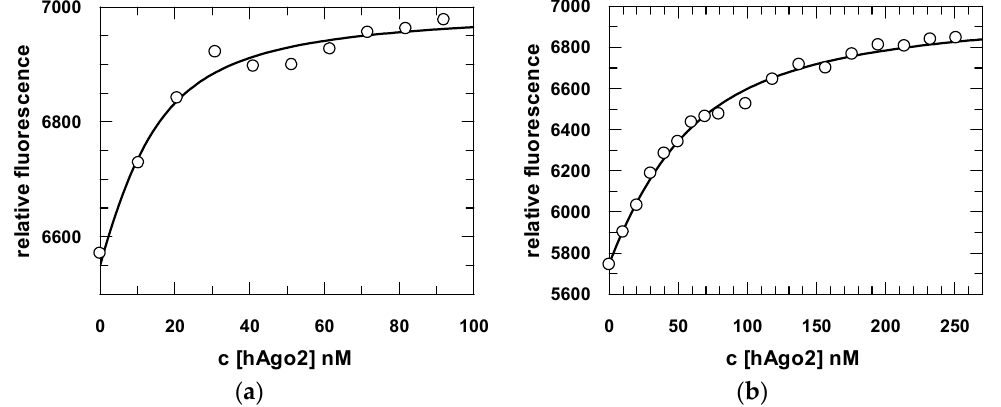
Figure 4. Fluorescence equilibrium titrations of hAgo2 with guide RNA. 20 nM of FAM-labeled guide RNA carrying a 5 ′ -G (s2b-FAM) without ( a ) or with ( b ) a phosphate group were titrated with increasing amounts of hAgo2. Data were fitted to a quadratic equation and a representative fit is shown. K d s of 7.5 ± 1.8 nM without a phosphate group and 34.7 ± 2.8 nM with a phosphate group at the guide 5 ′ -end were obtained.